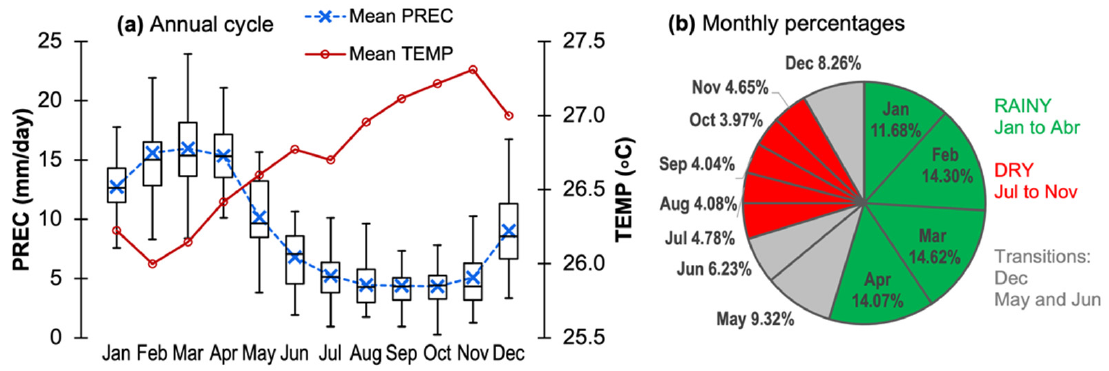
Figure 3. ( a ) Boxplot of PREC (mm/day) and TEMP (°C, only the climatological mean) for Belém station (period 1985–2020); ( b ) monthly percentages (relative to the annual total) of PREC, emphasizing the seasonal regimes.